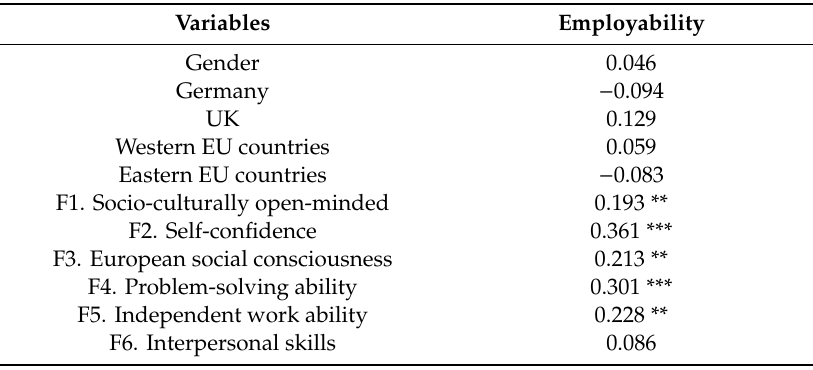
Table 6. Correlation between competences and employability expectations.